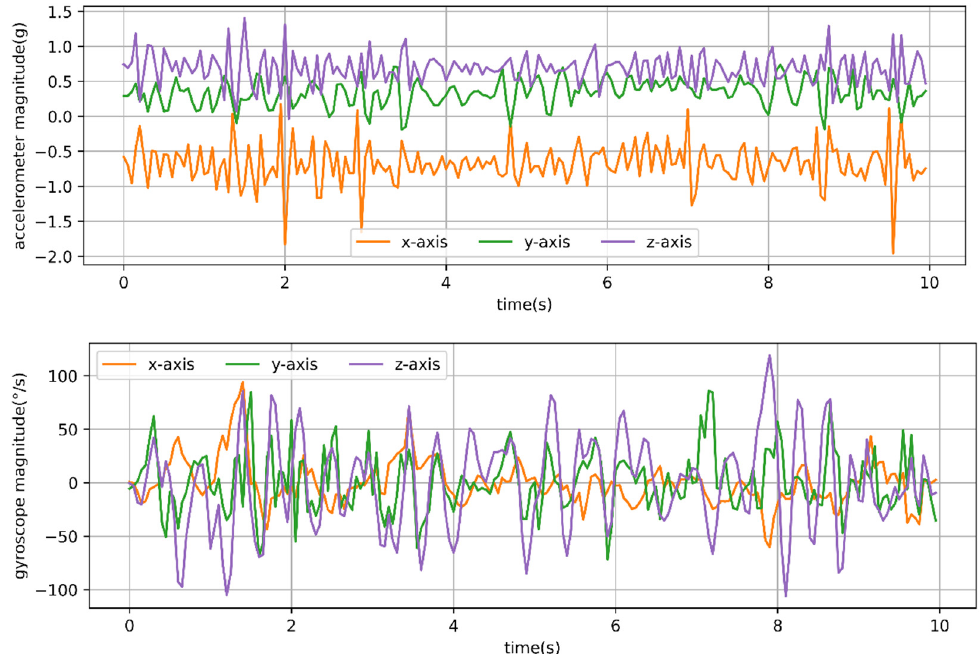
Figure 8. Time series of three-axis accelerometer and three-axis gyroscope signals from a 20 Hz sampling rate for observed behavior of 10 s of grazing. Acceleration was in g (9.8 m/s 2 ) units. Table 4. Features calculated for each time window (3, 5 and 11 s) based on x -, y - and z -axis accelerom- eter and gyroscope data. Equations adapted from